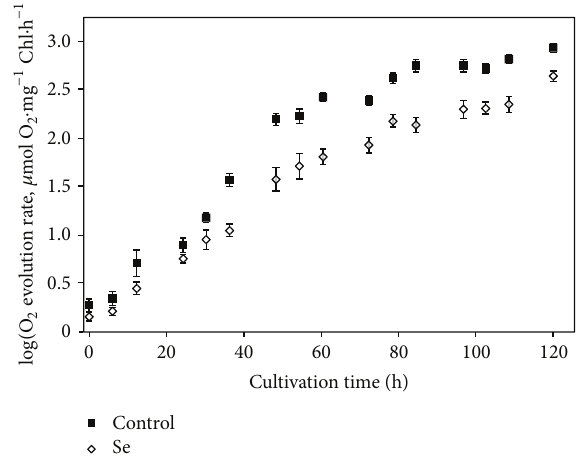
Figure 4: Photosynthetic oxygen evolution ( 𝜇 mol O 2 mg −1 Chl. h −1 ) by Chlorella sorokiniana in function of time for culture with 40 mg ⋅ L −1 of selenate and control culture (no selenate). Data are given as mean values ± S.D. of the